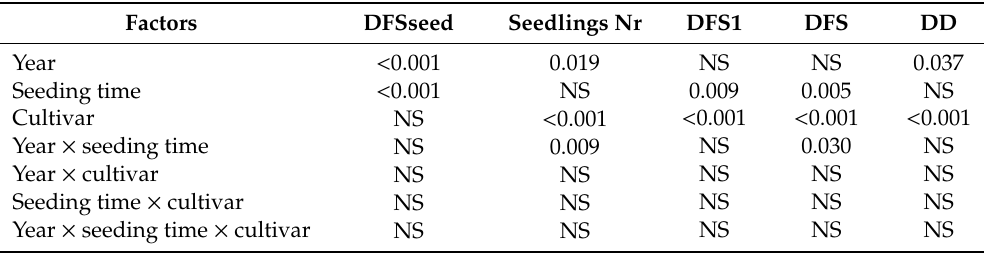
Table 1. Analysis of variance testing the e ff ects of year, seeding time, cultivar, and their interactions on days from seeding to the emergence (DFSseed), number of seedlings at the emergence (Seedlings Nr), days from the first seeding time (DFS1), days from seeding (DFS), and degree days (DD) to reach 75% green cover.